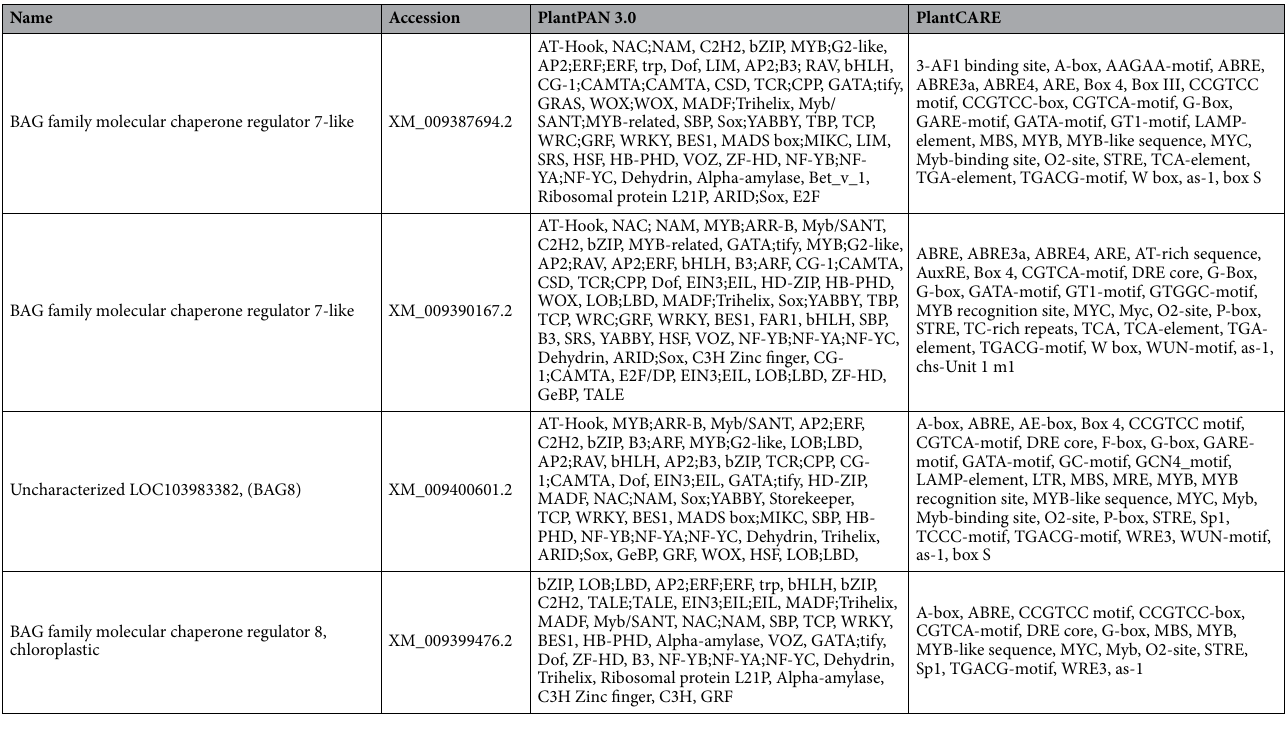
Table 3. Cis -regulatory elements present in the putative promoter sequences of the MusaBAG